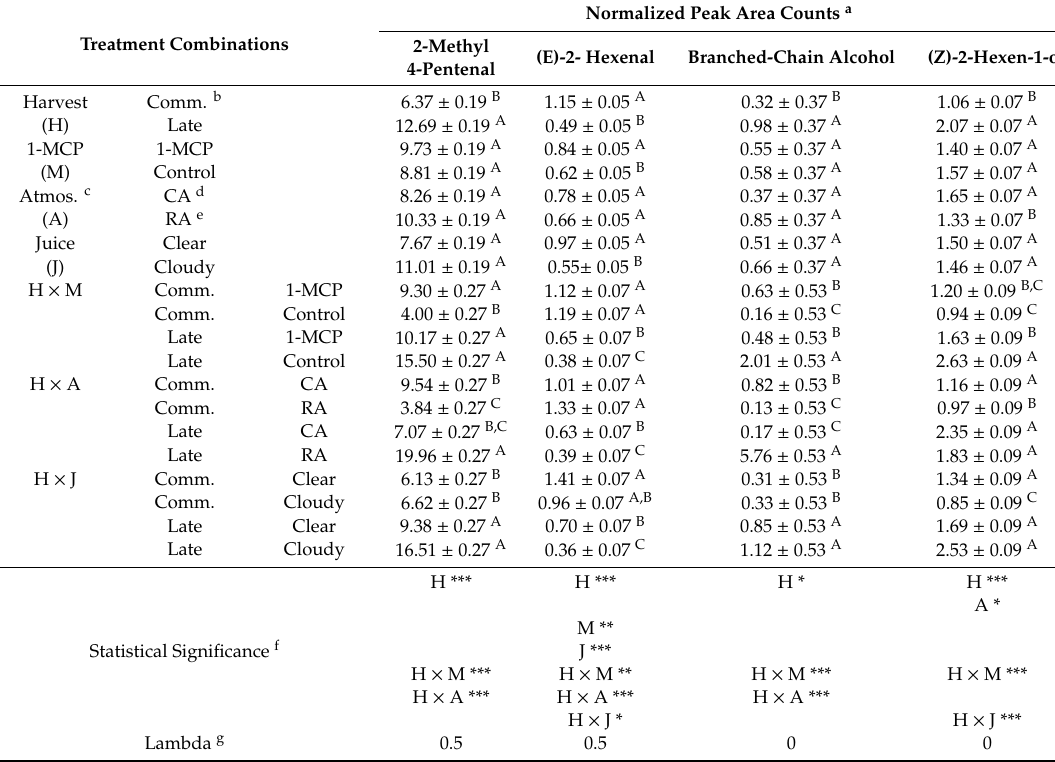
Table 3. Relative amounts of major aldehydes and alcohols identified in clear and cloudy juice samples from McIntosh apples harvested at commercial or late-harvest maturity, treated or untreated with 1-MCP and stored under CA or RA conditions for 4